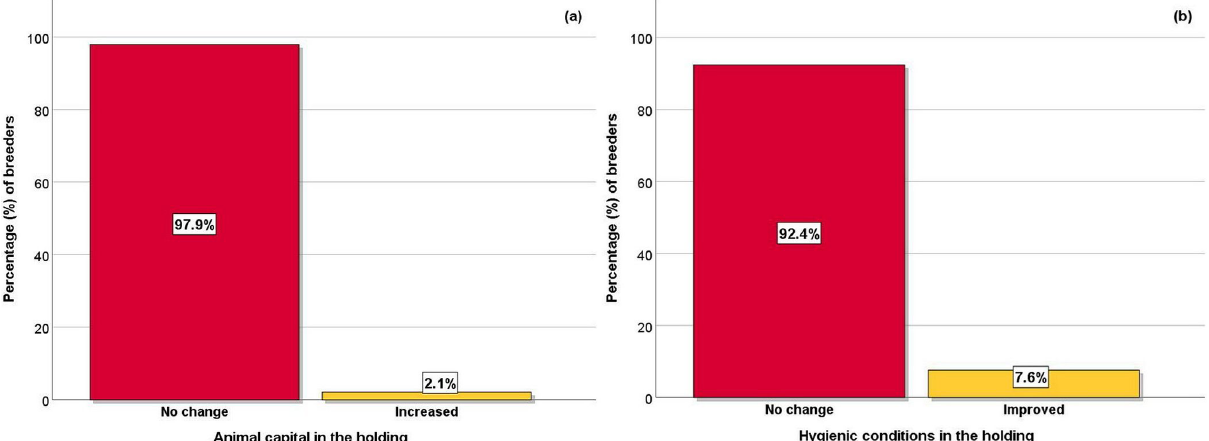
(type of the holding) − 0 . 005 × (number of raised sheep) − 11 . 624 × (farming system) + 15 . 359 and had a significant fit of the data ( − 2 log-likelihood statistic = 108.522, χ 2 = 11.983, P = 0.007). The number of raised sheep was the only significant variable (Wald(1) = 4.339, P =